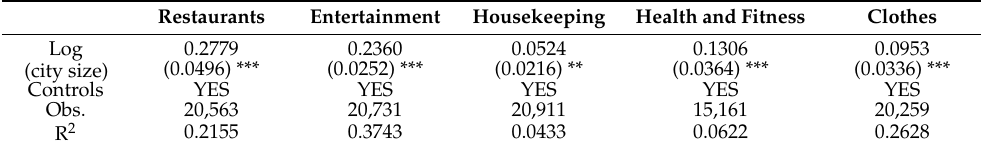
Table 3. Effect of city size on household expenditures; control variables are included. Restaurants Entertainment Housekeeping Health and Fitness